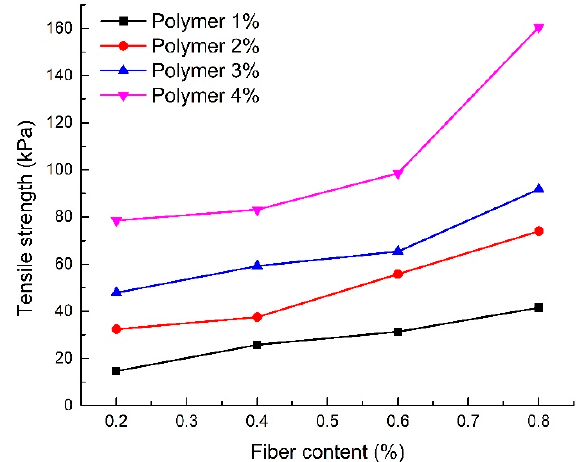
Figure 13. Tensile strength of reinforced sand with different fiber content.